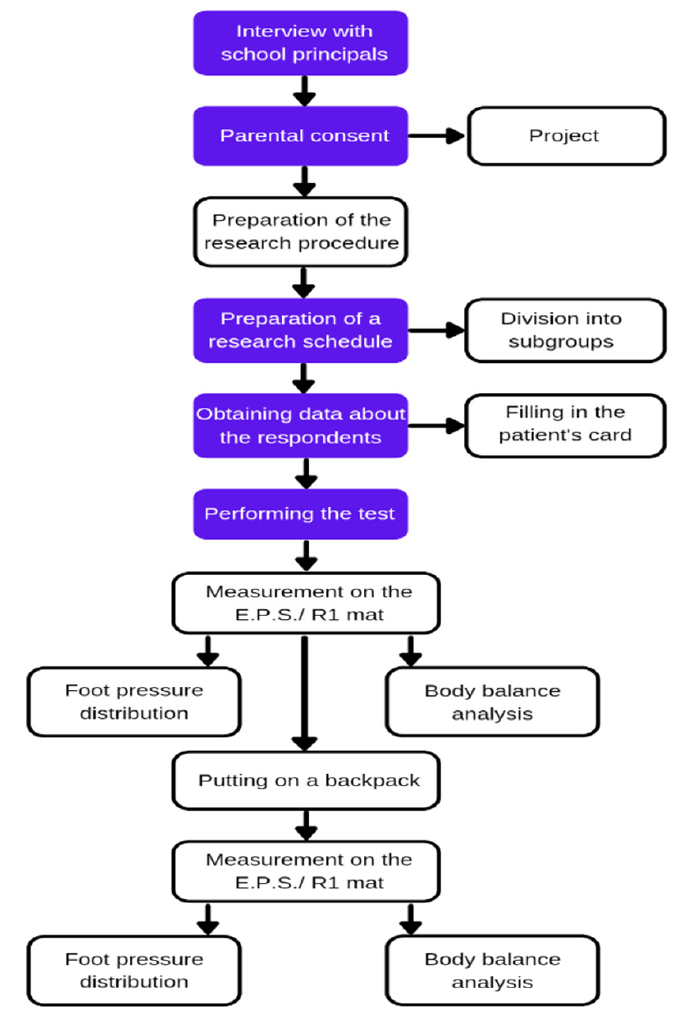
Figure 1. Scheme of the test procedure.